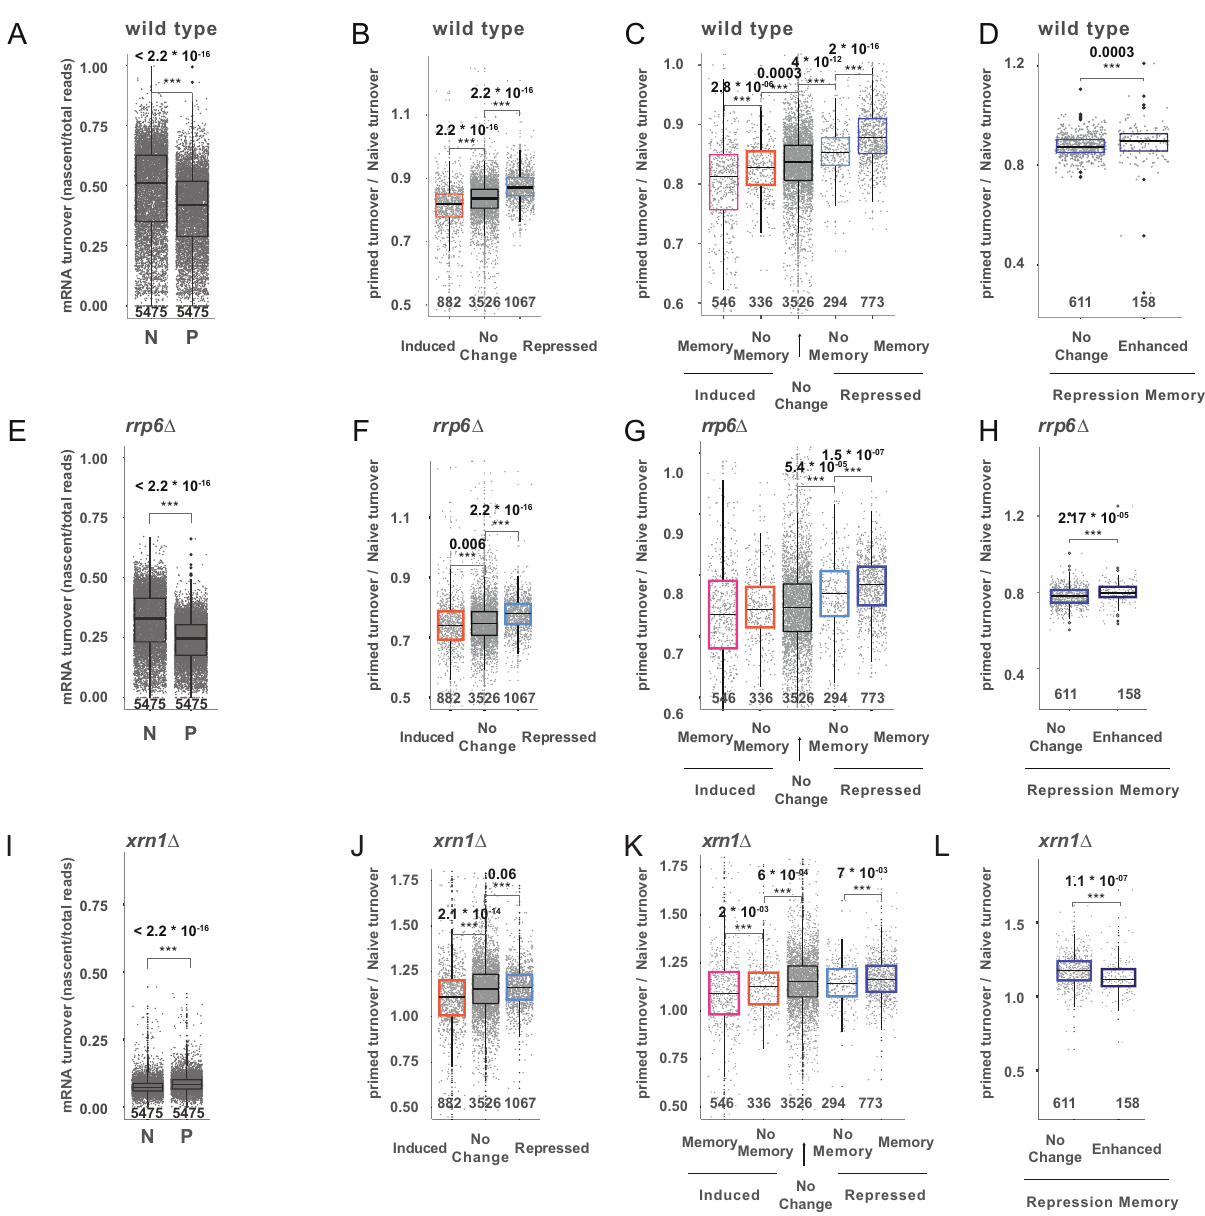
shown at the bottom of each boxplot. C As in B but for genes according to their transcriptional memory pro fi le. D , As in B but for genes with repression memory enhanced or not enhanced after RRP6 depletion. E – H As A-D but for the rrp6 Δ strain. I – L As A-D but for the xrn1 Δ strain. For all boxplots the number of genes examined isdepicted atthe bottom ofthe boxplot and the independent biological experiments n =3. First quantile, median and third quantile are de fi ned as the minimum,centerandmaximumboundsof thebox-plots.Two-sidedWilcoxontest was used for all (Fig. 5E, p -value < 2.2 ×10 − 16 ). As expected, this effect was particularly strongforCUTs,whichwereclearlystabilizedin rrp6 Δ (Supplementary Fig. 8A, p -value < 2.2 ×10 − 16 ). Having validated our RNA turnover measurements in rrp6 Δ , we investigated differences inmRNA turnover between naive and primed conditions. As in the wild-type strain, we observed a clear decrease in mRNA turnover in primed rrp6 Δ cells (Fig. 5E, Supplementary Fig. 7A, p < 2.2 ×10 − 16 ). This shows that the observed mRNA stabilization in primed cells (decreased mRNA turn- over) does not depend exclusively on the nuclear exosome, but that regulation of the cytoplasmic mRNA decay is also involved. In